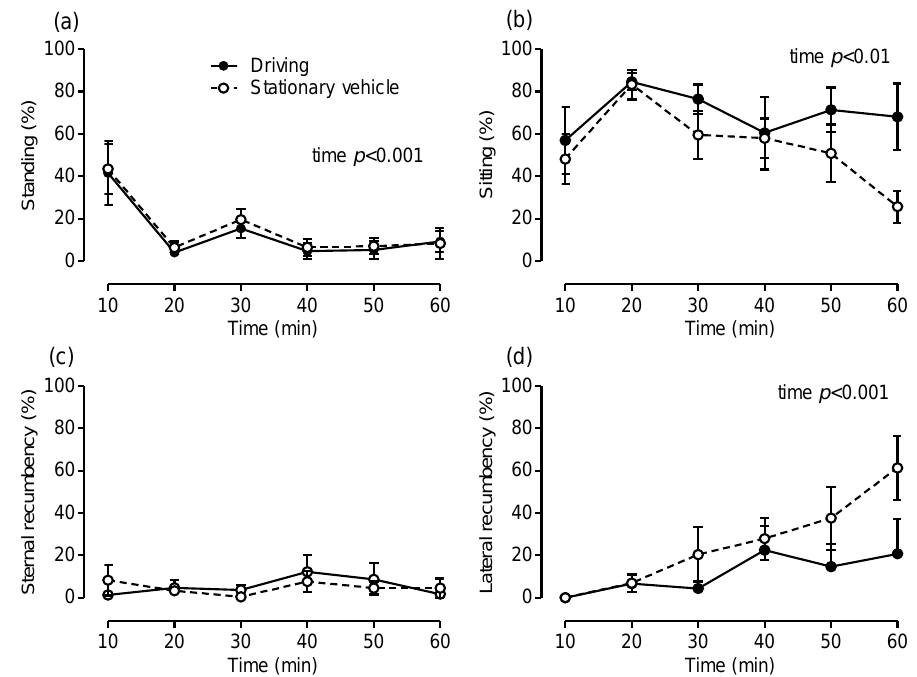
Figure 5. Time spent ( a ) standing, ( b ) sitting, ( c ) in sternal recumbency and ( d ) in lateral recumbency in dogs either transported for one hour ( n = 6) or left in the transport cage in the stationary transport vehicle ( n = 6; week 2). Times are given as percentage for each position for subsequent 10 min intervals. Values are means ± SEM, significant differences are indicated in the figures.